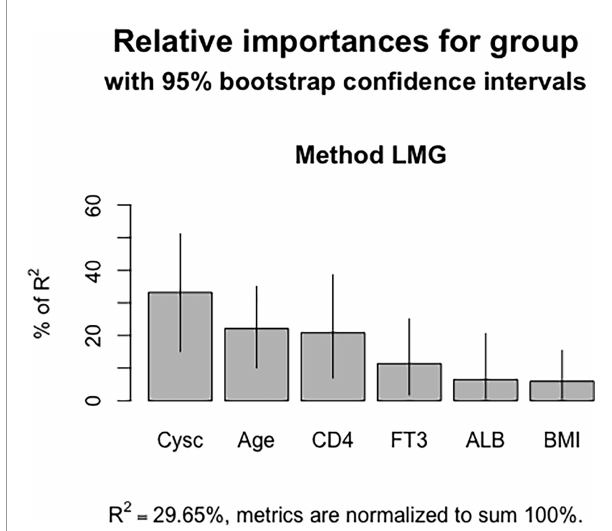
FIGURE 5 | Coef fi cient of determination of the nomogram model. Cysc contributed the most in the model, followed by age, CD4+ T cell counts, FT3 and ALB.